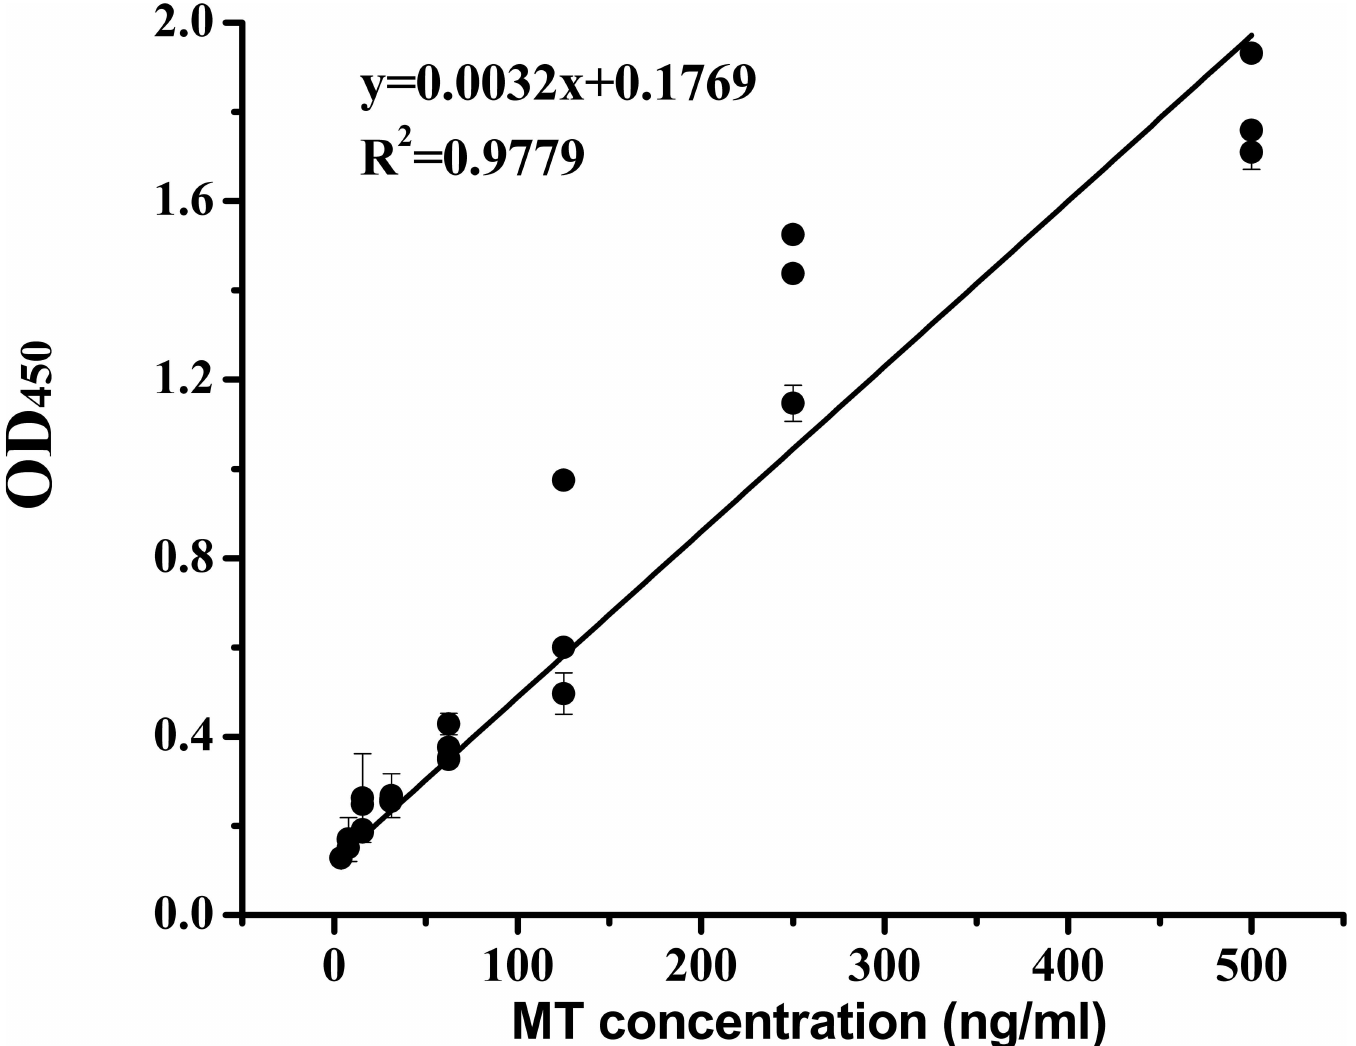
Fig 4. The ELISA standard curve for purified MT. Data are expressedas mean ± standard deviation(n = 5).